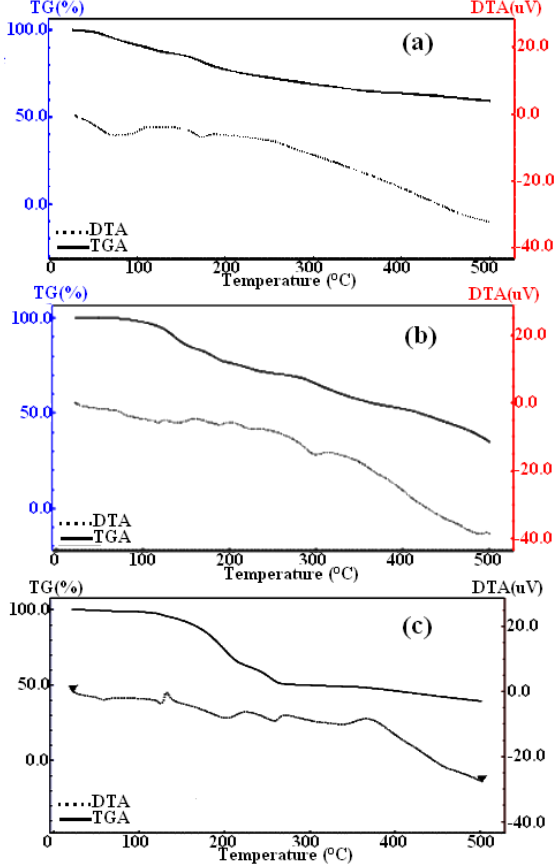
Figure 7. TG- and DTA- thermograms of ( a ) Co(II), ( b ) Zn(II), and ( c ) Cu(II) complexes.